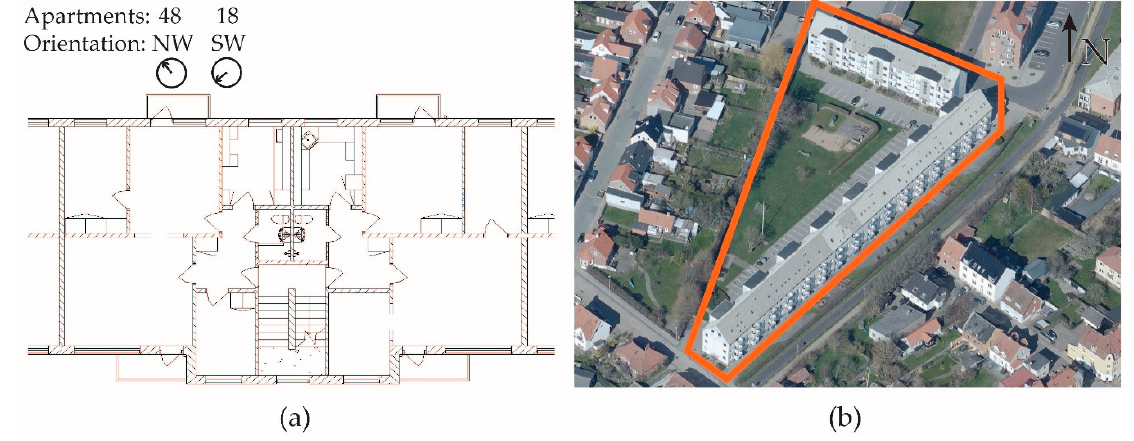
Figure 2. ( a ) Plan and orientation of the Danish case study building complex; and ( b ) overview of the building complex and its surroundings.